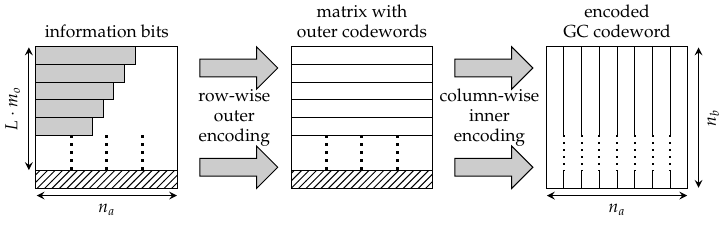
Figure 5. Encoding of a GC